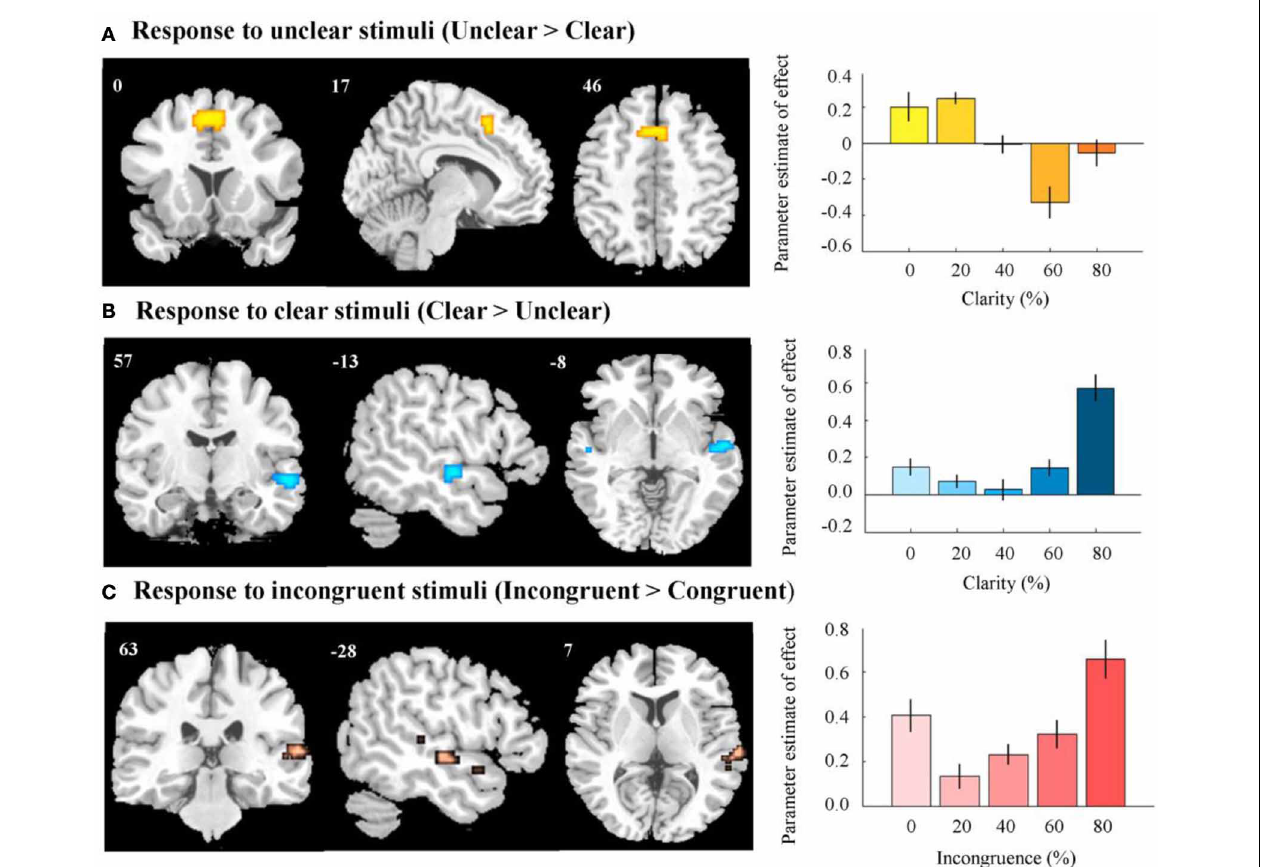
FIGURE 5 | fMRI results. (A) Activation in anterior cingulate and supplementary motor area in response to unclear, compared to clear information. Right panel indicates response in peak activated voxel as a result of increasing level of clear information. (B) Activation in right STG/STS in response to clear, compared to unclear information. Right panel indicates response in peak activated voxel as a result of increasing level of clear information. (C) Activation in right STG/STS in response to incongruent, compared to congruent information. Right panel indicates